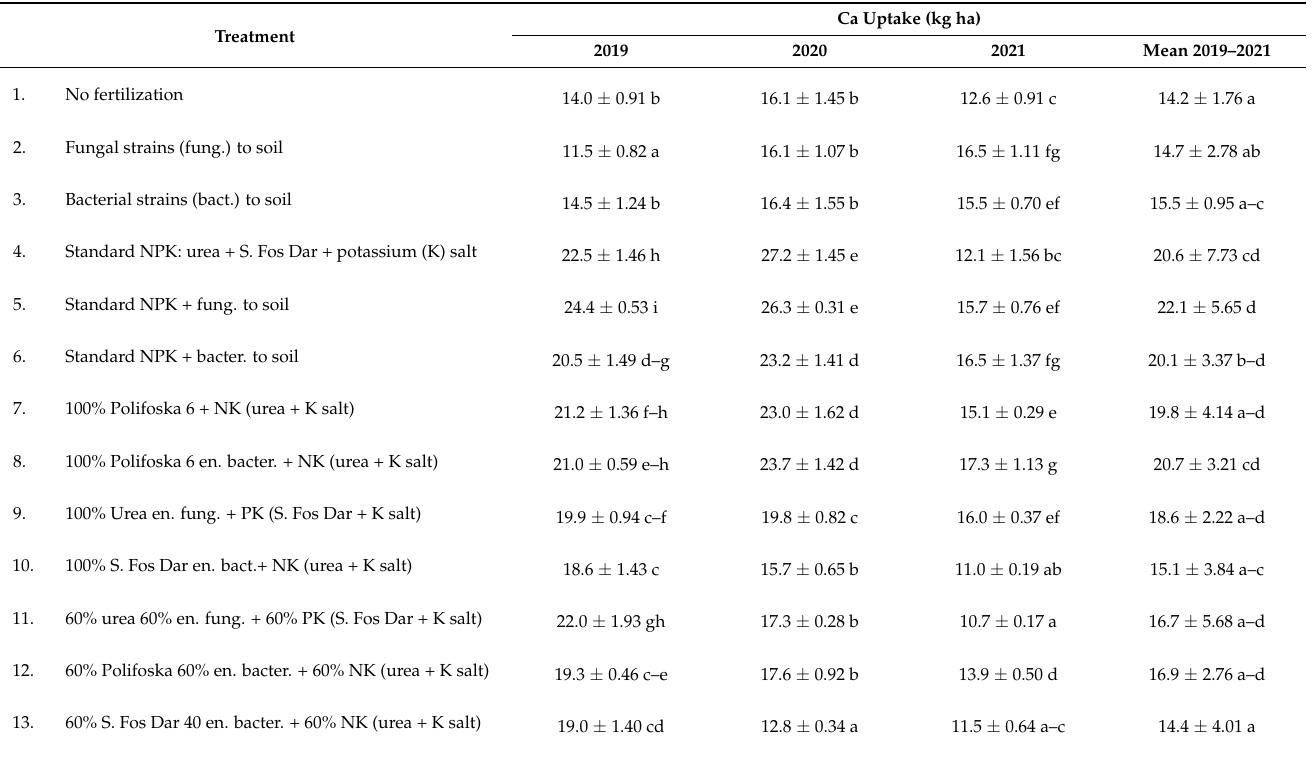
Table 10. Ca uptake by weed shoots in the apple orchard, 2019–2021.